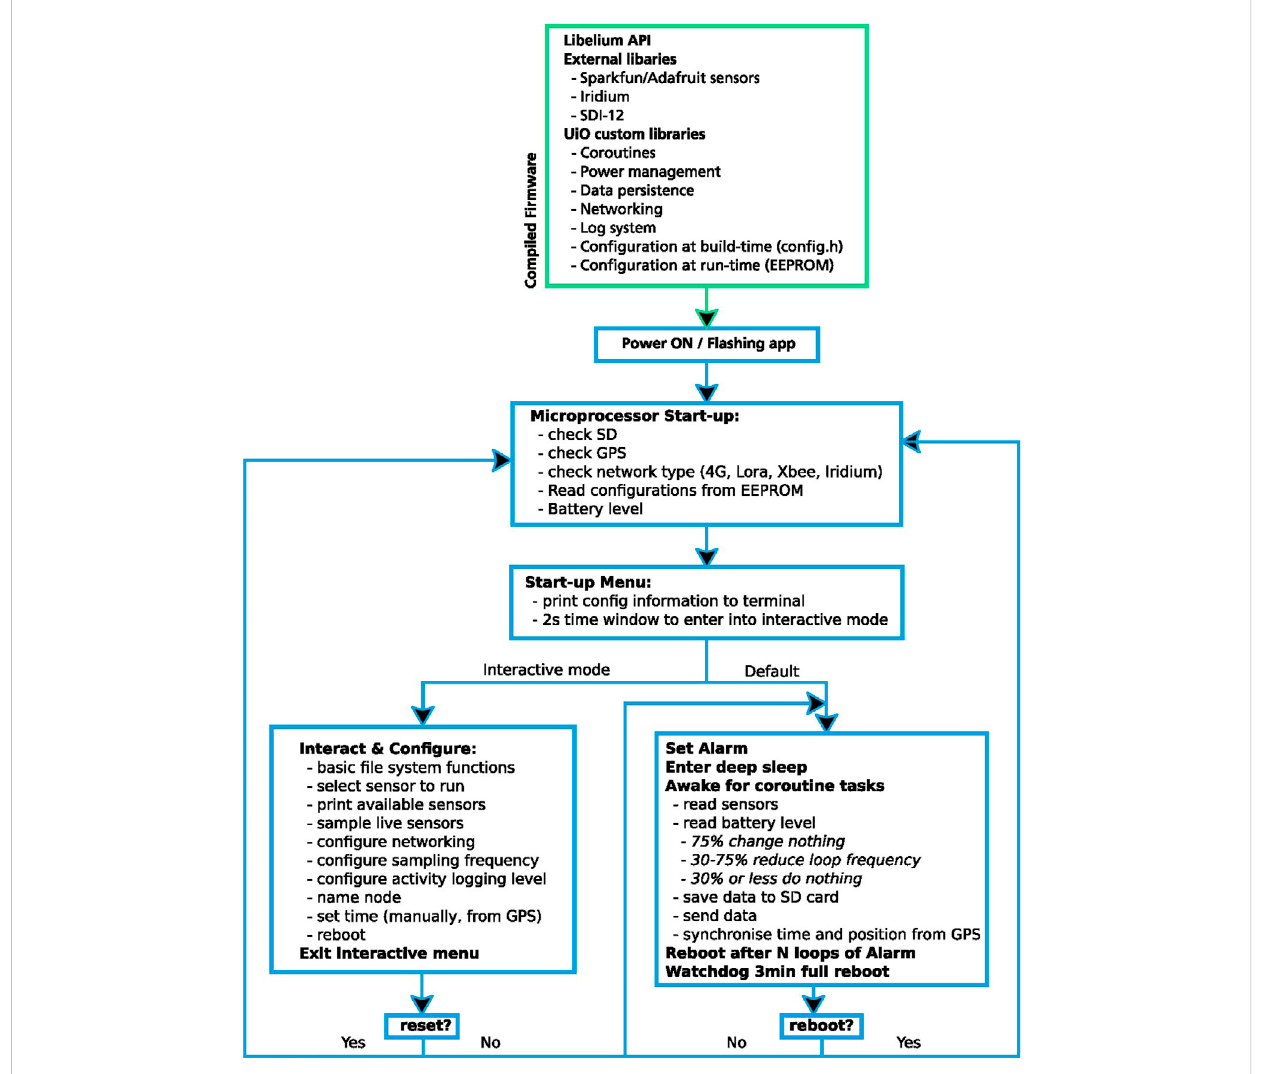
FIGURE 4 Diagramsummarizingthenode fi rmwarealgorithm:1)ingreenthelibrariescompiledintoa fi rmwarethen fl ashedtothenode ’ smicroprocessor,and 2) in blue, the on-board logic structure of the fi